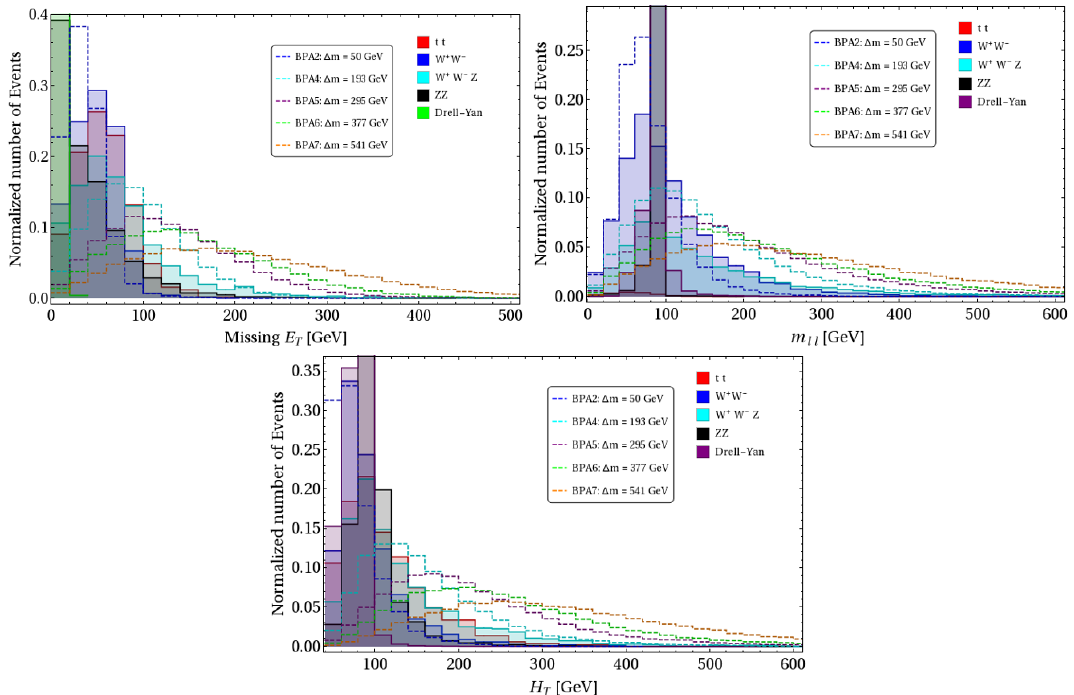
Figure 21 . Missing energy ( =E T ), invariant mass of dilepton ( m ‘‘ ) and e(cid:11)ective mass ( H T ) dis- tributions of ‘ + ‘ (cid:0) + ( =E T ) events from signal (Benchmark points as in table 2) and dominant SM background events at LHC with p s = 14 TeV